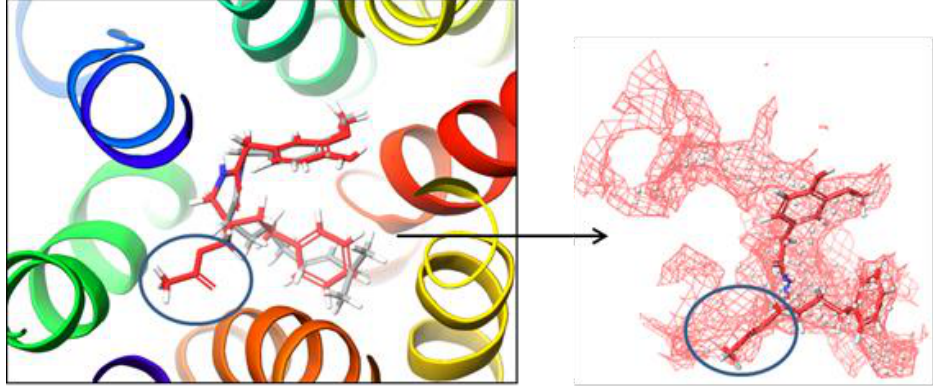
Figure 4. Binding mode of capsaicin (grey) and lead compound CID 44330438 (red) to the NorA efflux pump ligand binding site.